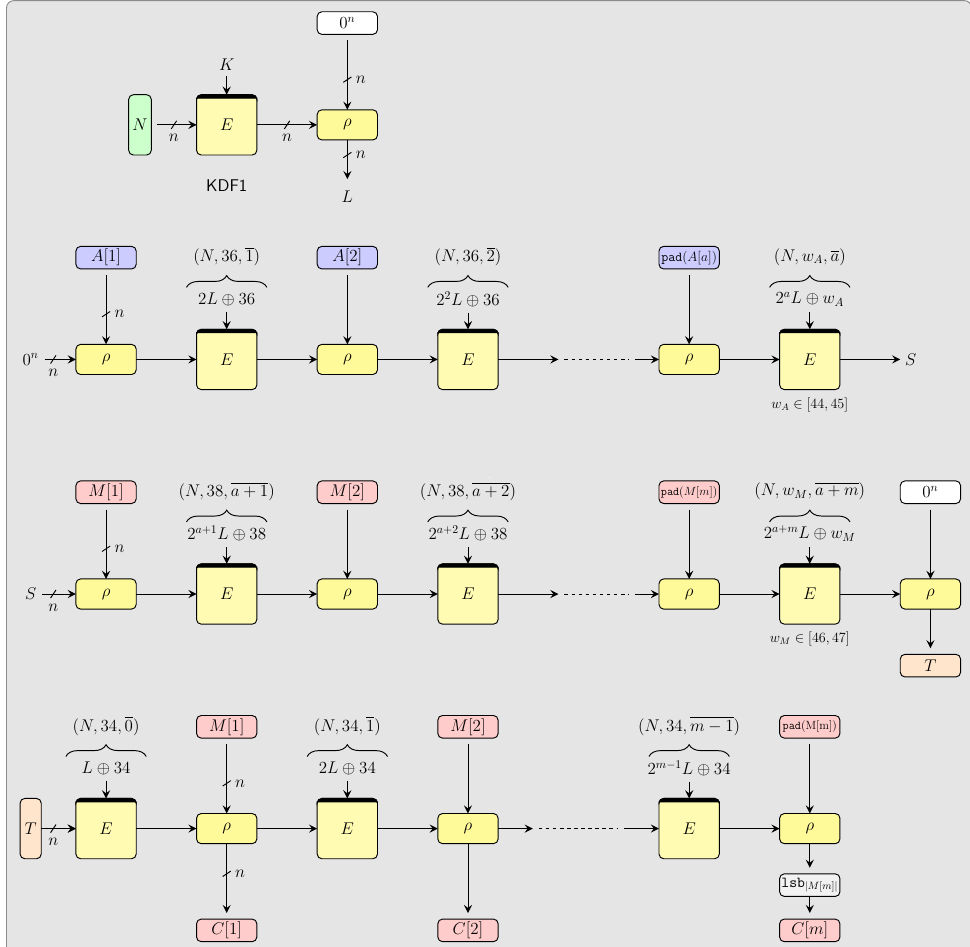
Figure 11: Remus-M with ICE1 ( Remus - M 1). (Top) Key derivation. (Middle-Top) Processing of AD (Middle-Bottom) Processing of M authentication (Bottom)